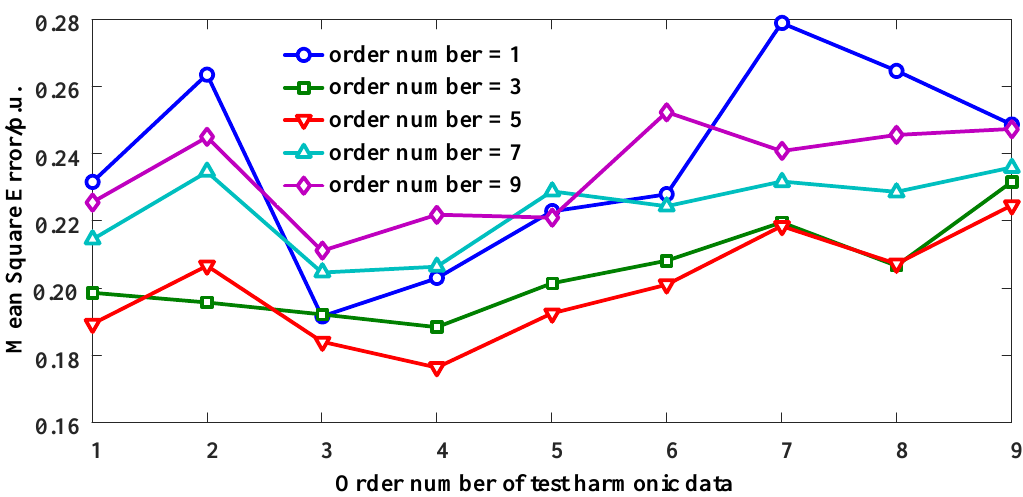
Figure 5. MSE of the out-of-sequence measurement (OOSM) algorithm under various training and test sample sets. Each line represents the results under specific disorder level training